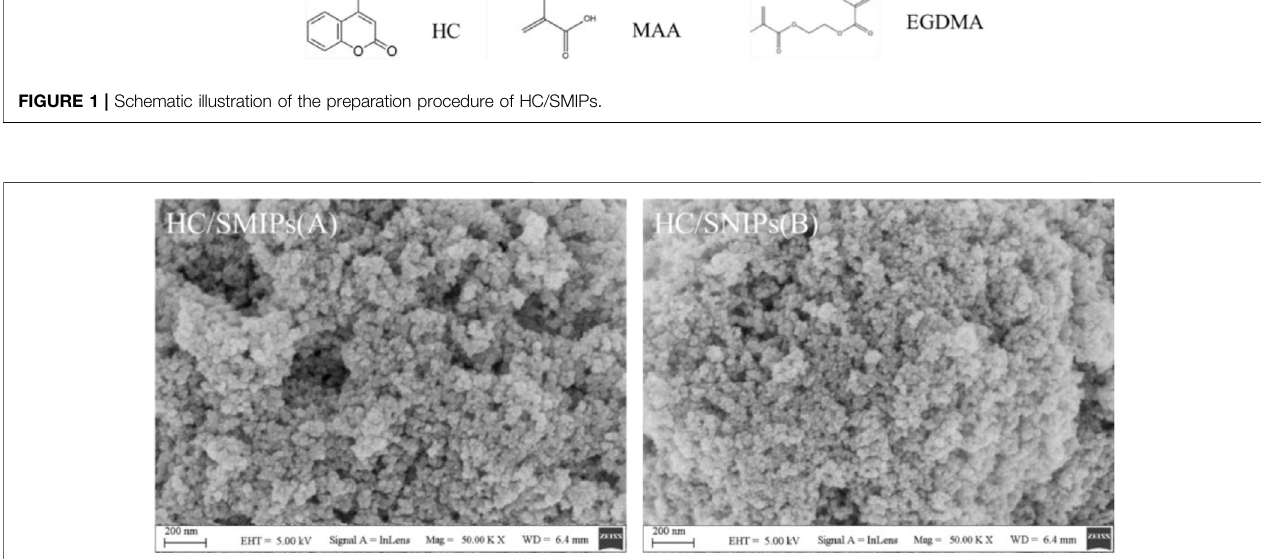
FIGURE 2 | SEM images of the HC/SMIPs (A) and HC/NIPs (B) .